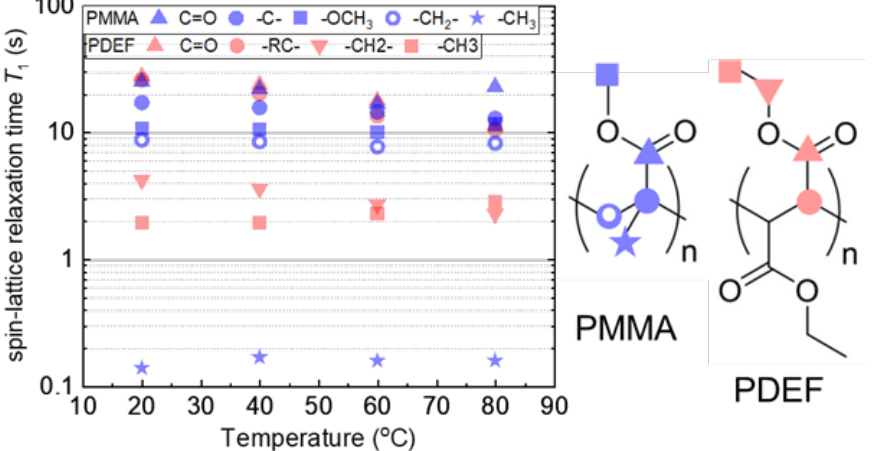
Figure 3. Temperature dependence of spin-lattice relaxation time T 1 for PMMA (blue symbol) and PDEF (red symbol). The symbols on the chemical structure correspond to T 1 plotted on the graph.